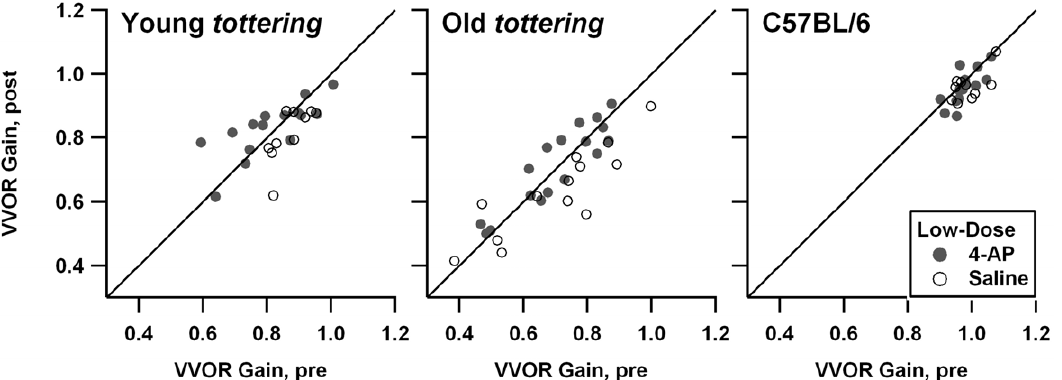
Figure 2. Comparison of vestibulo-ocular reflex (VVOR) gain before and after saline or 4-AP, in the low-dose experimental series. Symbols and format are identical to Figure 1. This larger series of experiments with a somewhat differing set of animals suggests that 4-AP can reduce habituation in the mutants.